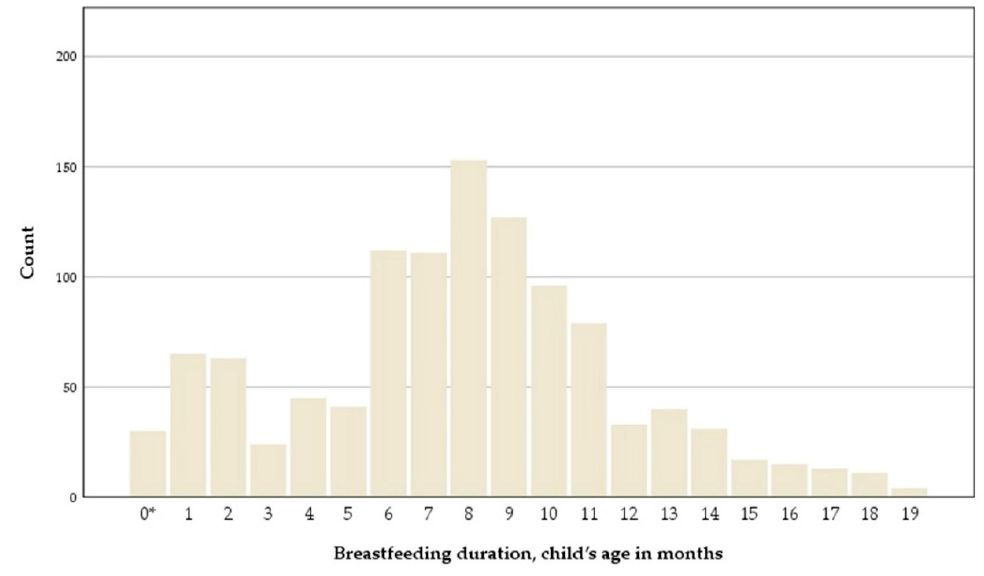
Figure 8. Histogram of breastfeeding duration. * Never breastfed.